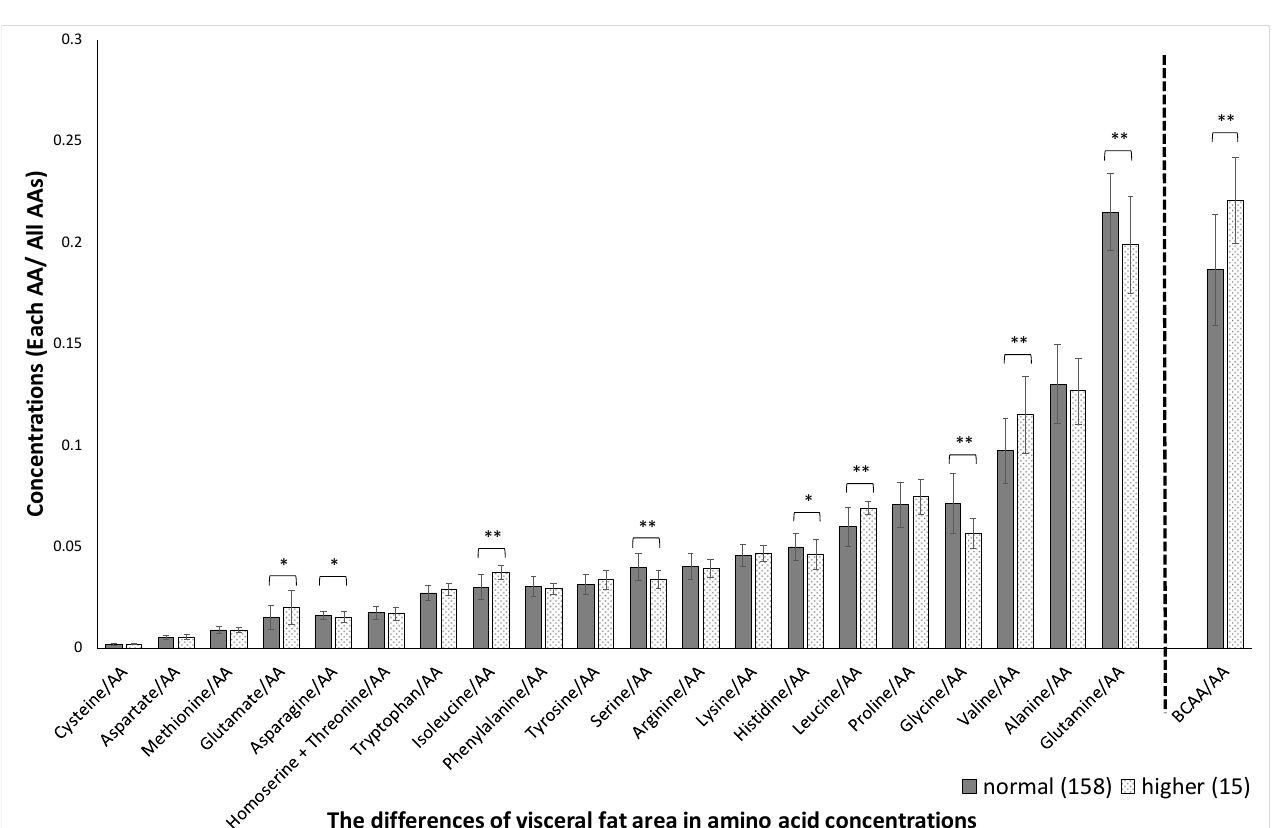
Figure 5. Visceral fat area-related differences in amino acid concentrations. The absolute concentration was divided by the total AA concentration, yielding the relative concentration. Participants were divided into two groups based on the visceral fat area 100. AAs, amino acids; BCAAs, branched-chain amino acids. * p < 0.05, ** p < 0.01 in visceral fat area < 100 cm 2 versus ≥ 100 cm 2 .